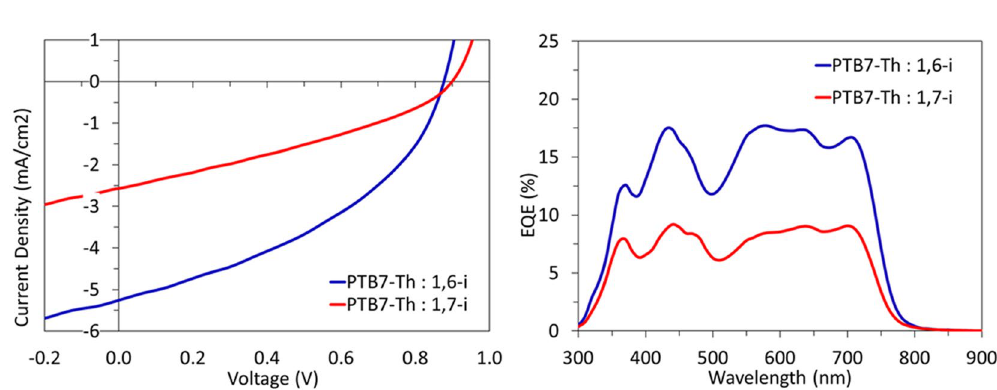
Figure 7. J –V curves (left) and EQE spectra (right) of 1,7-i (red) and 1,6-i (blue) based